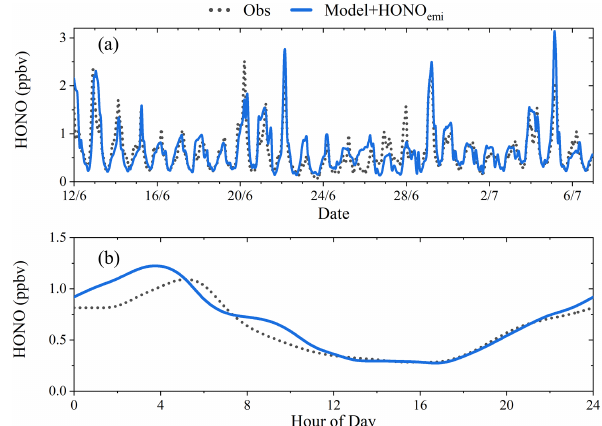
2010; Liu et al., 2019; Vogel et al., 2003; Xue et al., 2020;